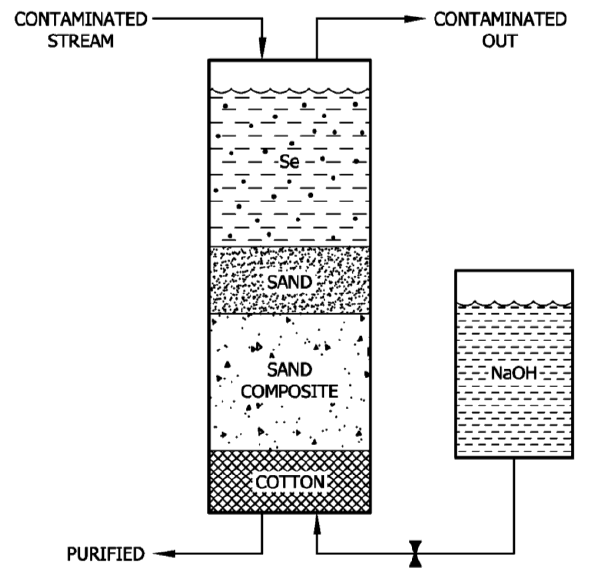
Figure 1. Schematic of the bench scale column set up. After Se (IV) removal from the contaminated stream, 1M NaOH solution can be flushed into the column to desorb Se (IV) in the form of sodium selenite by exiting through the top of the column.